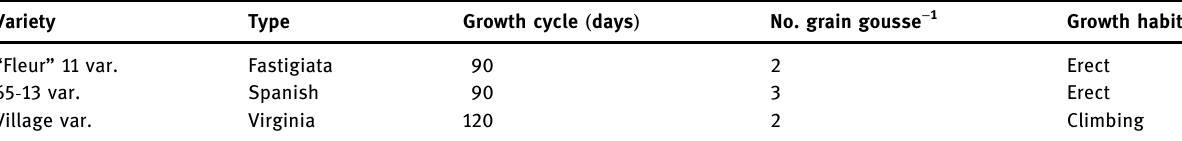
Table 1: Agronomic characteristics of the varieties used ( IRAD - Dschang 2010 )